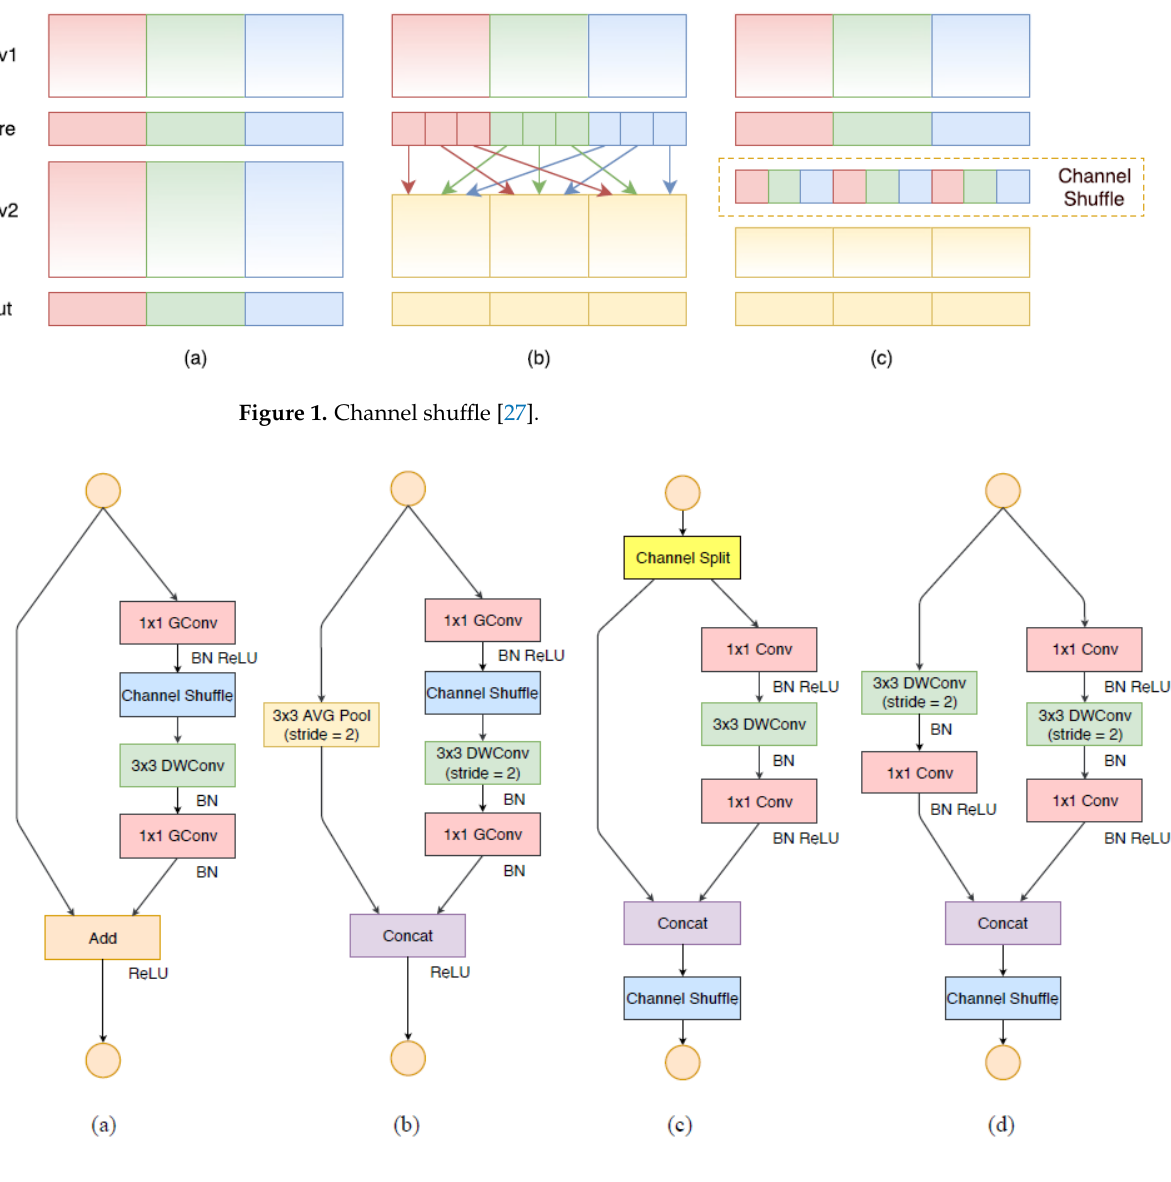
Figure 2. ShuffleNet units